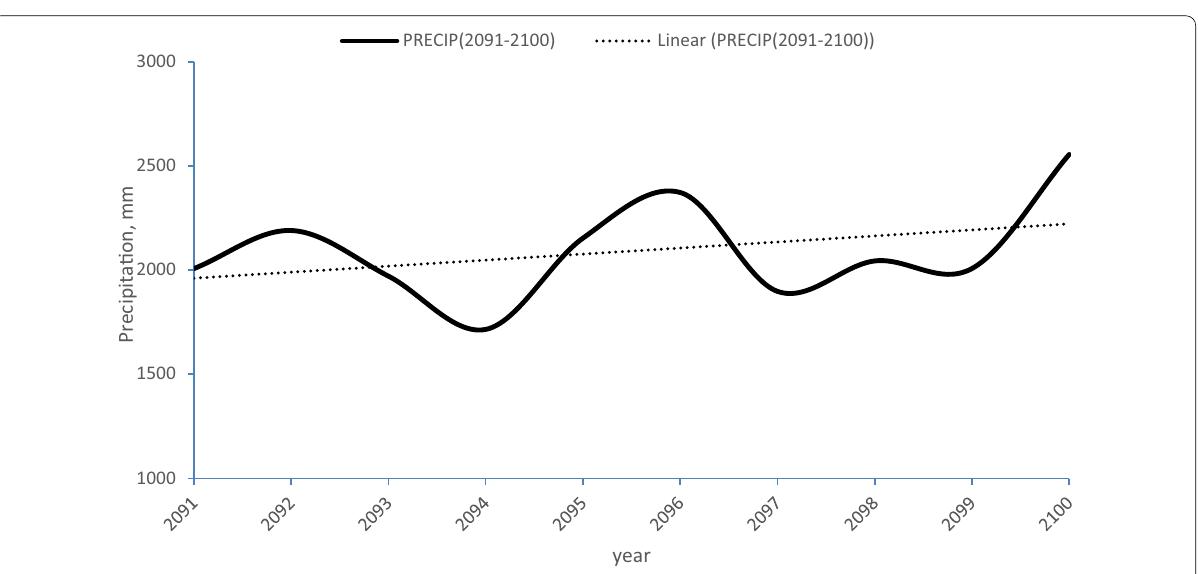
Fig. 10 Projected annual precipitation trend in the long-term (2091–2100) for A1B